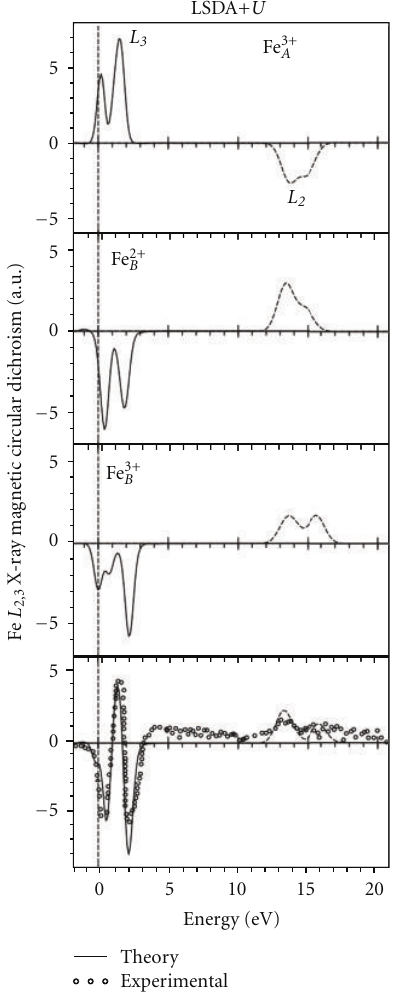
Figure 8: Fe L 2,3 XMCD spectra in Fe 3 O 4 calculated with the LSDA+ U approximation [191] in comparison with the experimen- tal data (circles)